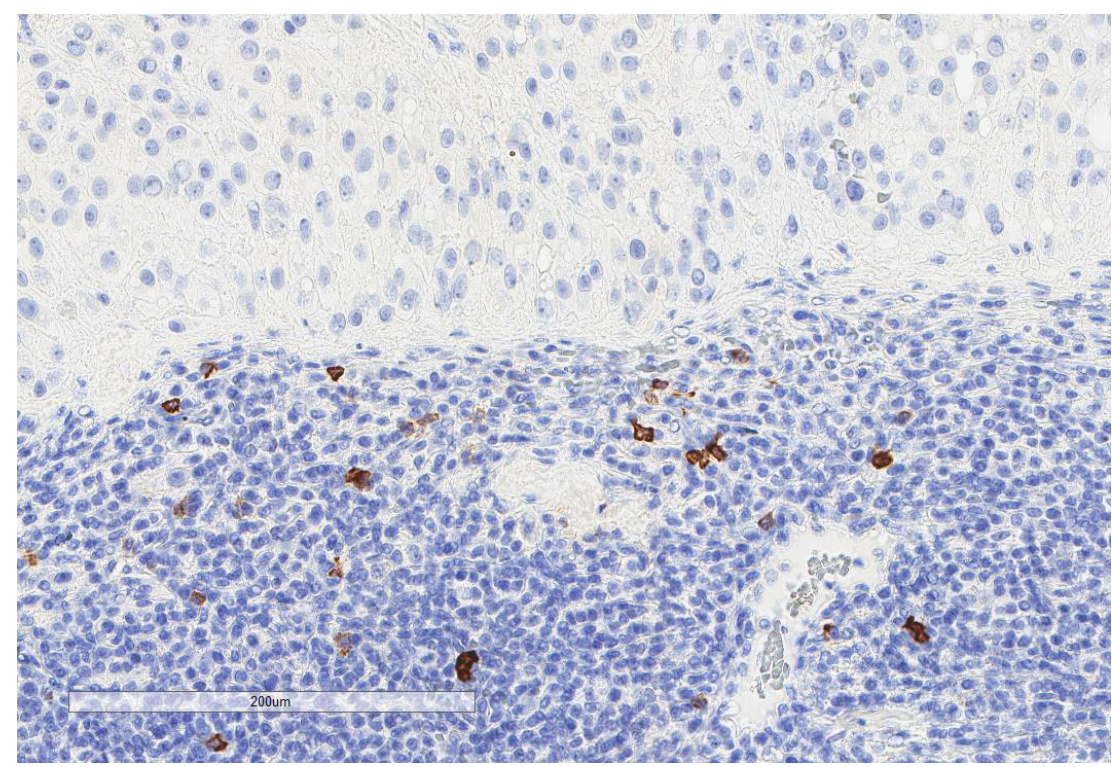
Figure 5. Representative microscopic image (×200 magnification) of low CD8 expression (red circle).